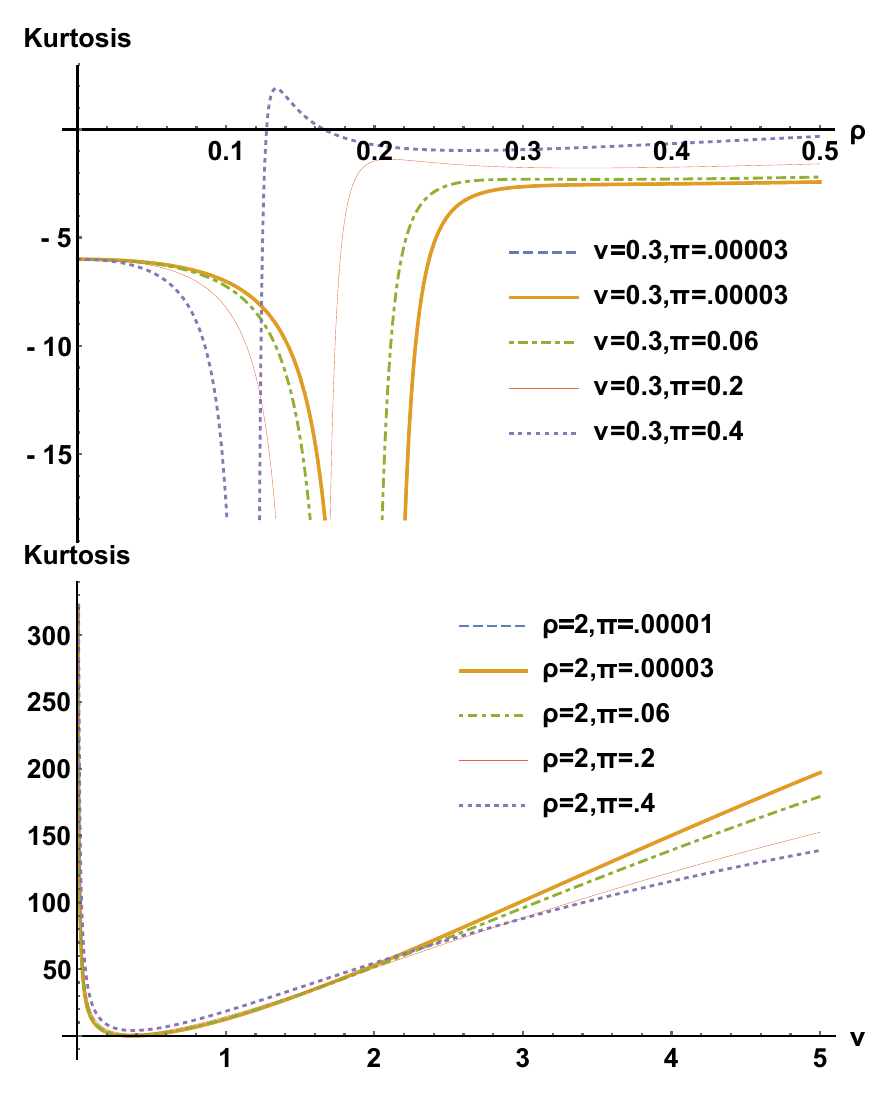
Figure 7 – Plots of kurtosis of ZIAHPD for particular values of its parameters.